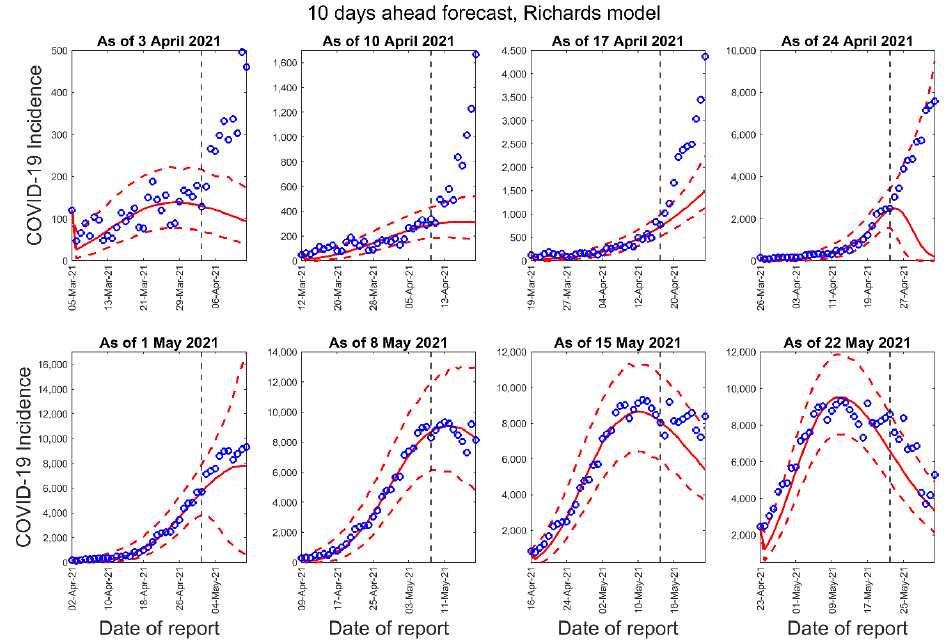
Figure 4. Ten-days ahead forecasts of the COVID-19 epidemic curves in Nepal by calibrating the Richards model for eight different periods. Blue circles correspond to the data points; the solid red line indicates the best model fit, and the red dashed lines represent the 95% prediction interval. The vertical black dashed line represents the time of the start of the forecast